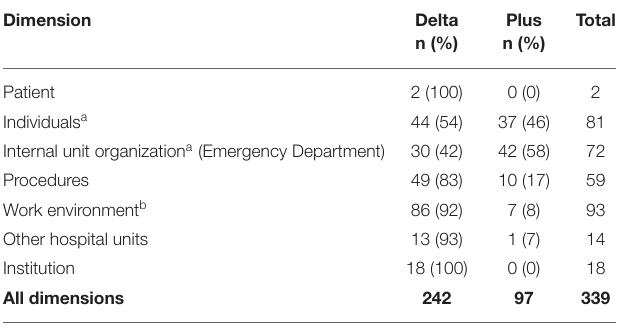
TABLE 3 | Number of deltas and pluses across different dimensions.